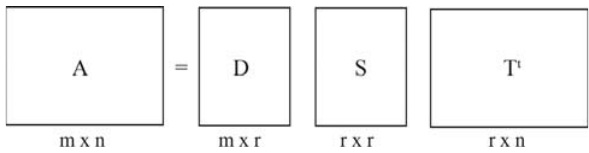
Figure 2 - Schematic of the singular value decomposition of a rectangular document by term matrix. A is the matrix of document by terms, or pro- teins by their contact vectors; D has orthogonal, unit-length columns ( D t D = I n ); T has orthogonal, unit-length columns ( T t T = I n ); m is the num- ber of rows of A, or the numbers of proteins; n is the number of columns of A ; n is the number of columns of A , or the length of the contact vector; r is the rank of A m (cid:6) min ( m, n ).